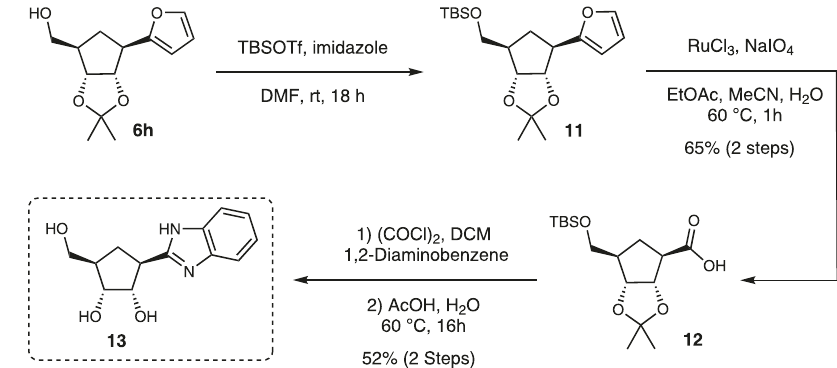
Fig. 8 Late-stage modi fi cation strategy. Modi fi cation of furan to benzaimidazole derived